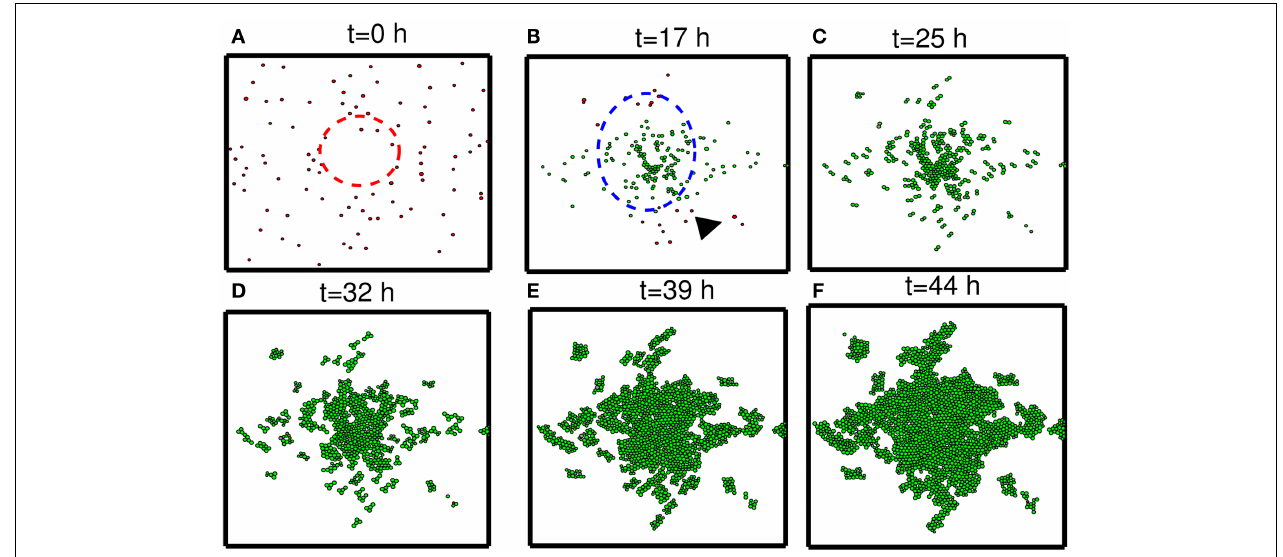
the center of the removed area again in order to turn the migratory switch ( M < th M , A > th A ) off and make these cells grow ( M > th M , A < th A ).This growing mass of tumor may be visible for secondary surgery, leading to eradication of invisible migratory cells. Domain size = [0 . 25, 0 . 75] × [0 . 25, 0 . 75] ⊂ [0, 1] 2 .